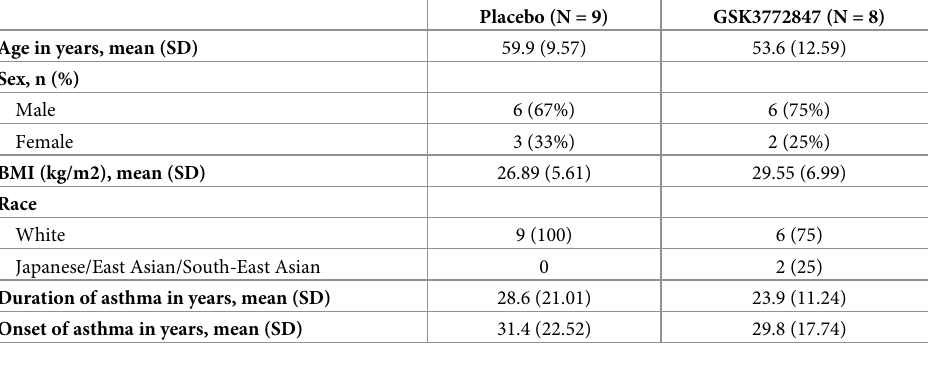
Table 1. Baseline demographics and